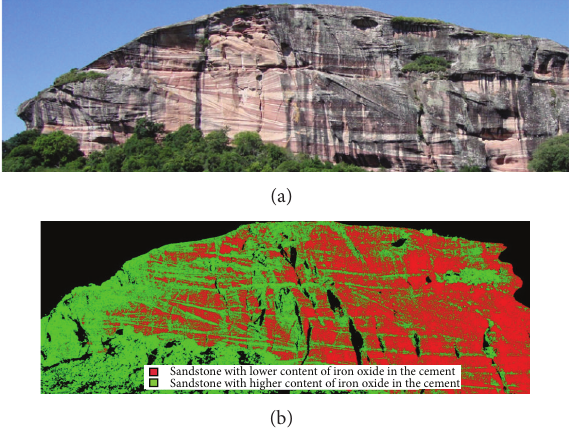
Figure 13: Comparison between the classified point cloud (b) and the reference image from the outcrop